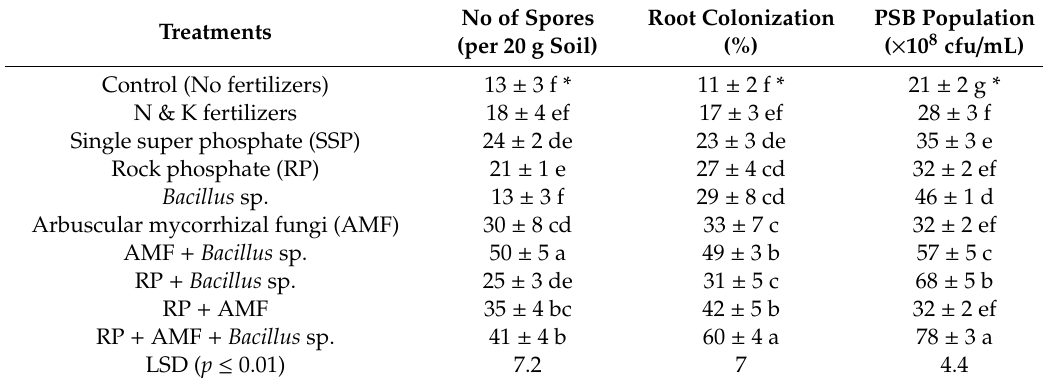
Table 7. Soil spore’s density and PSB population, and AMF wheat roots colonization as a ff ected by the inoculation of AMF and PSB with